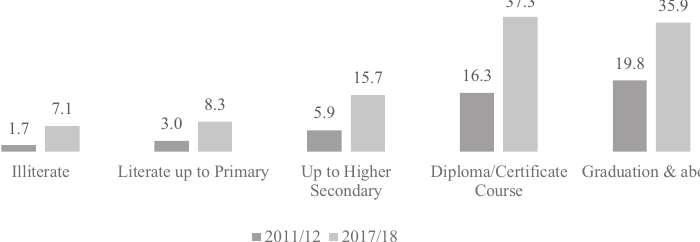
Figure 3. Distribution of youth unemployment rate across the